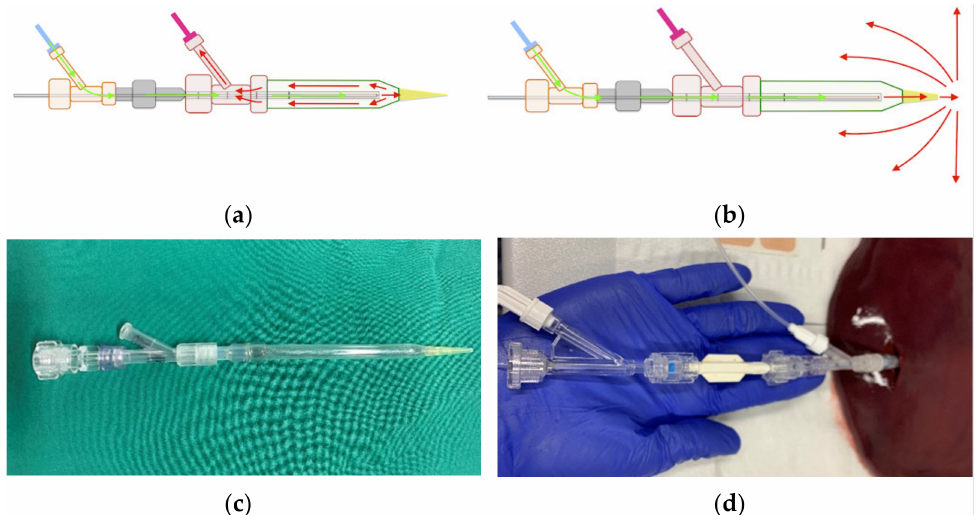
Figure 1. Diffusion circulation in the ( a ) closed spacer circuit and ( b ) open spacer circuit. Cooling fluid circulates through the spacer at a temperature of 20 ◦ C and ( a ) drains into an external calorimeter or ( b ) diffuses into external tissue. In ( c ) is shown the real closed spacer prototype, as well as ( d ) the experimental setup using the closed